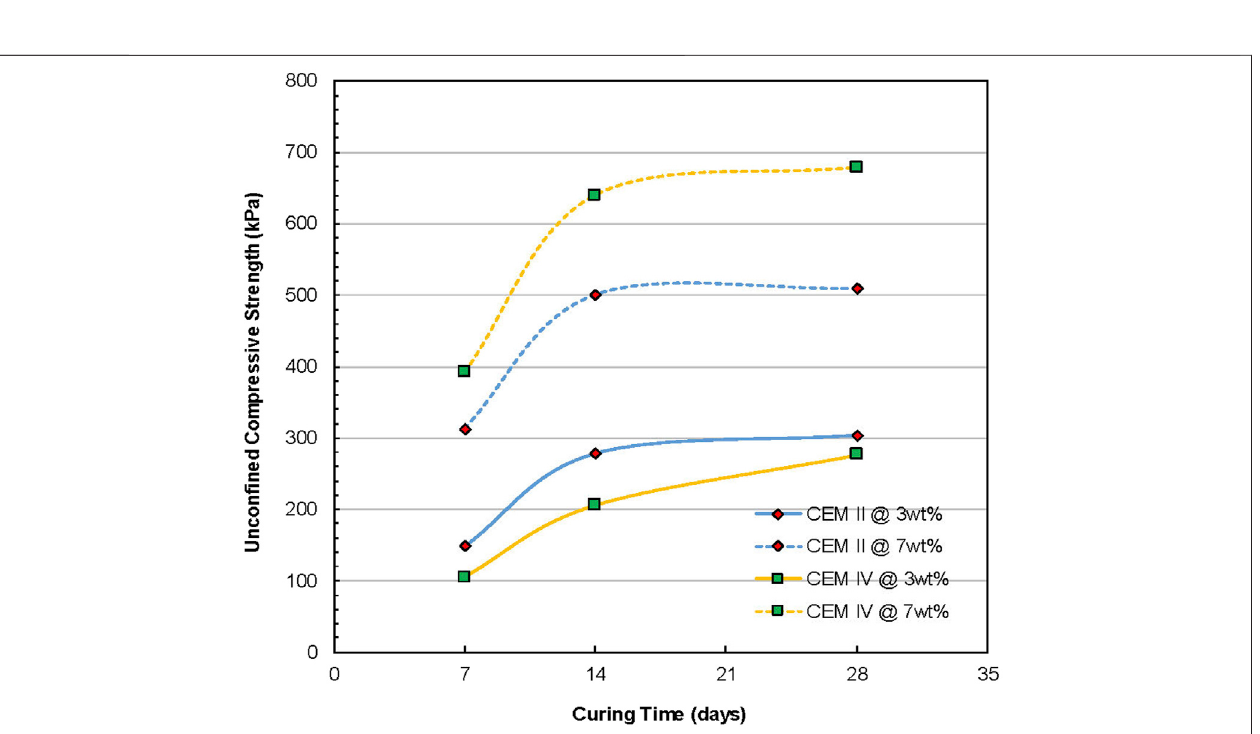
FIGURE 3 | pH pro fi le results for the tested mine tailings.